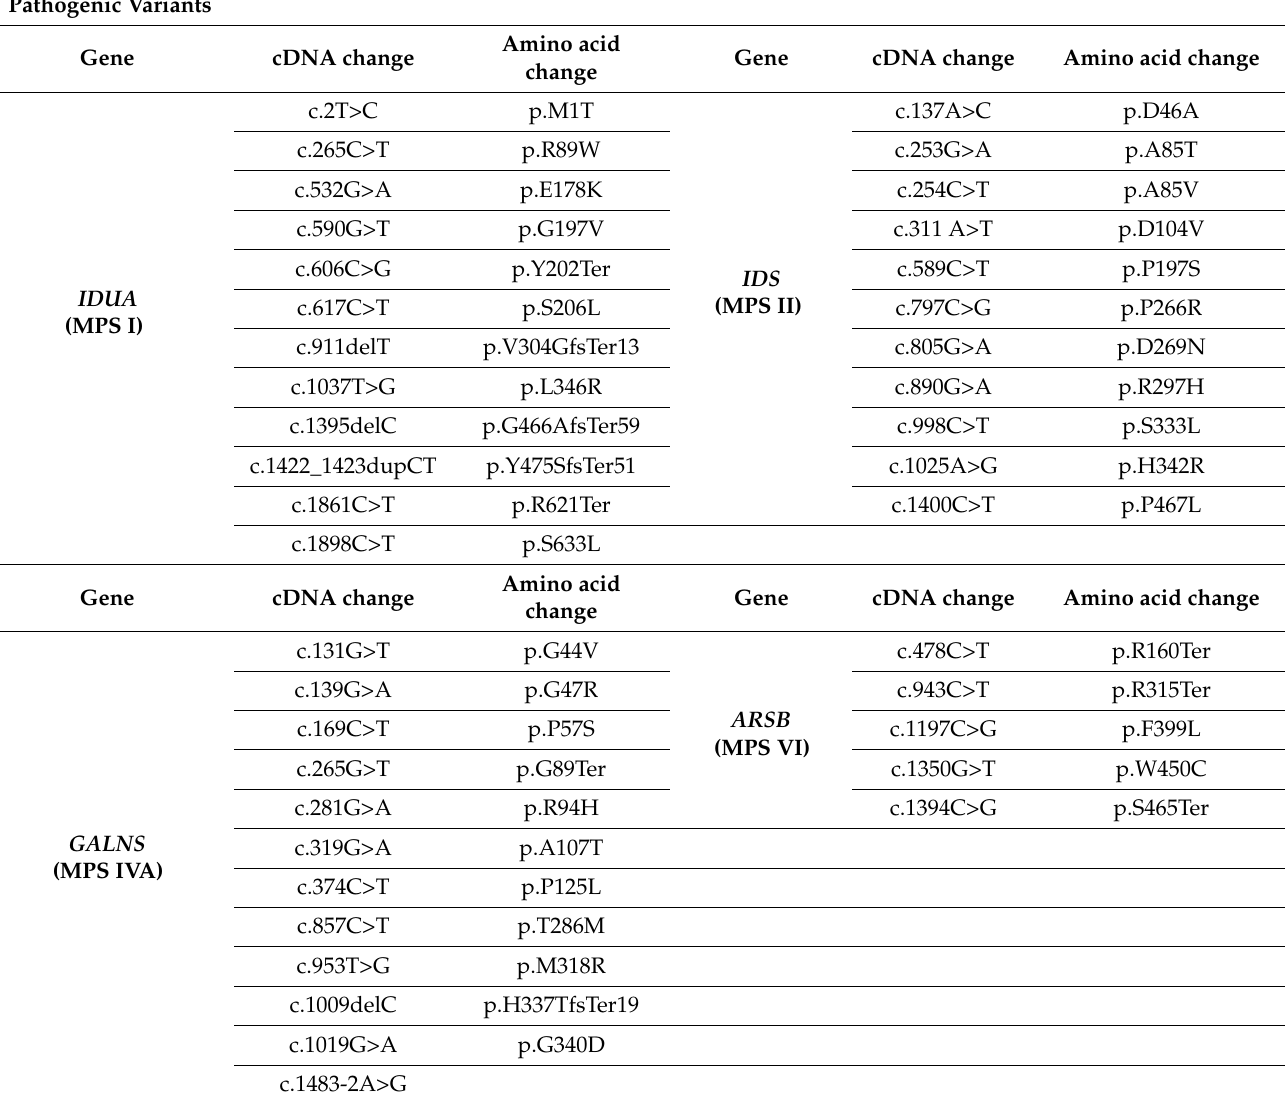
Table 1. Pathogenic variants of MPS genes, i.e., IDUA , IDS , GALNS , and ARSB defined by the ACMG